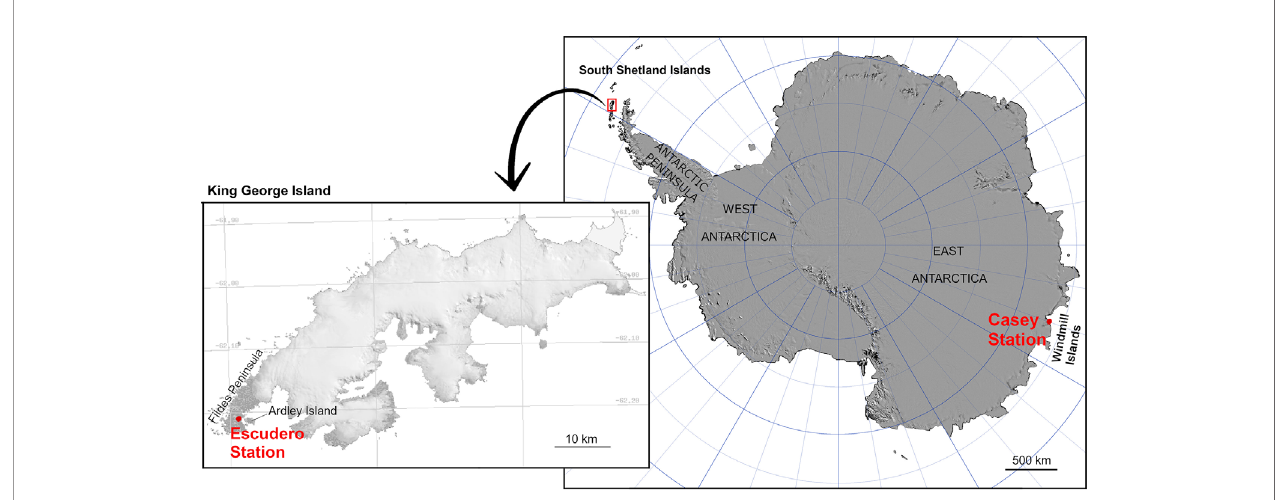
FIGURE 1 | Location of the South Shetland Islands and Windmill Islands (Casey Station), Antarctica with inset of King George Island showing location of Escudero Station (original source: the Scienti fi c Committee on Antarctic